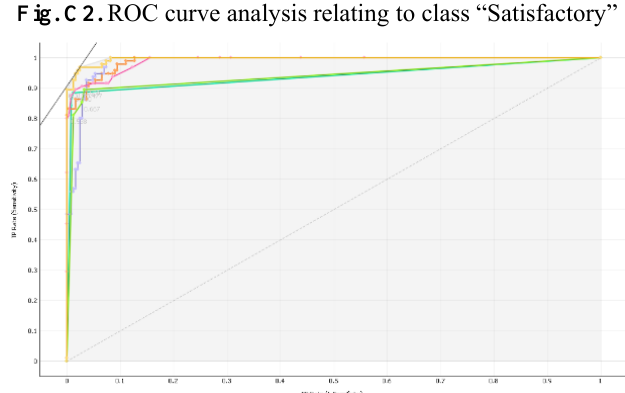
Fig. C3. ROC curve analysis relating to class “Poor”